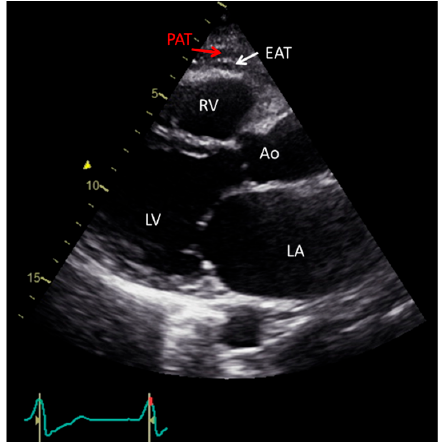
Figure 1. Transthoracic echocardiographic view showing EAT and PAT as echo-lucent areas in front of the RV free wall. EAT is pointed by a white arrow and PAT by a red arrow. Ao: aorta; EAT: epicardial adipose tissue; LA: left atrium; LV: left ventricle; PAT: pericardial tissue; RV: right ventricle. Cardiac CT has been increasingly used for assessment of EAT/PAT (Figure 2) [15]. A − 190 to − 3 HU on contrast enhanced CT scans is accurate and reproducible for